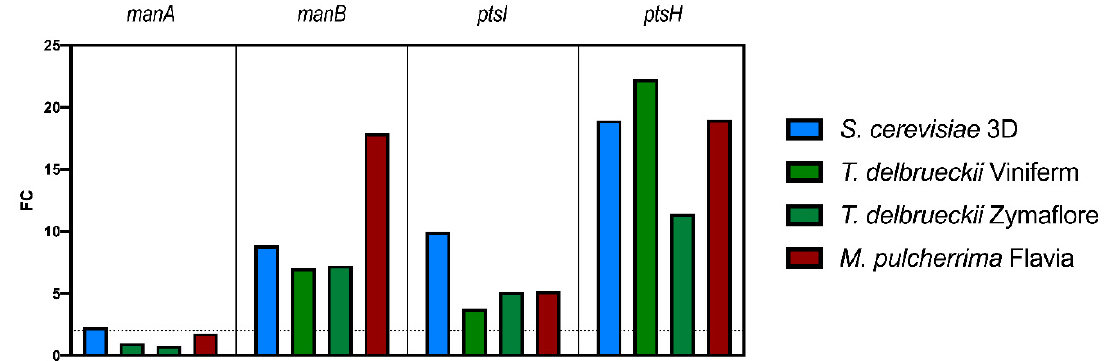
Figure 4. Relative expression as fold change (FC) of manA , manB , ptsI, and ptsH in natural wines fermented with different yeast inoculation regimes by the end of malolactic fermentation, using the expression in S. cerevisiae QA23 wine as the reference condition. FC = 2 is shown in the graph as the threshold for considering a gene to be upregulated.